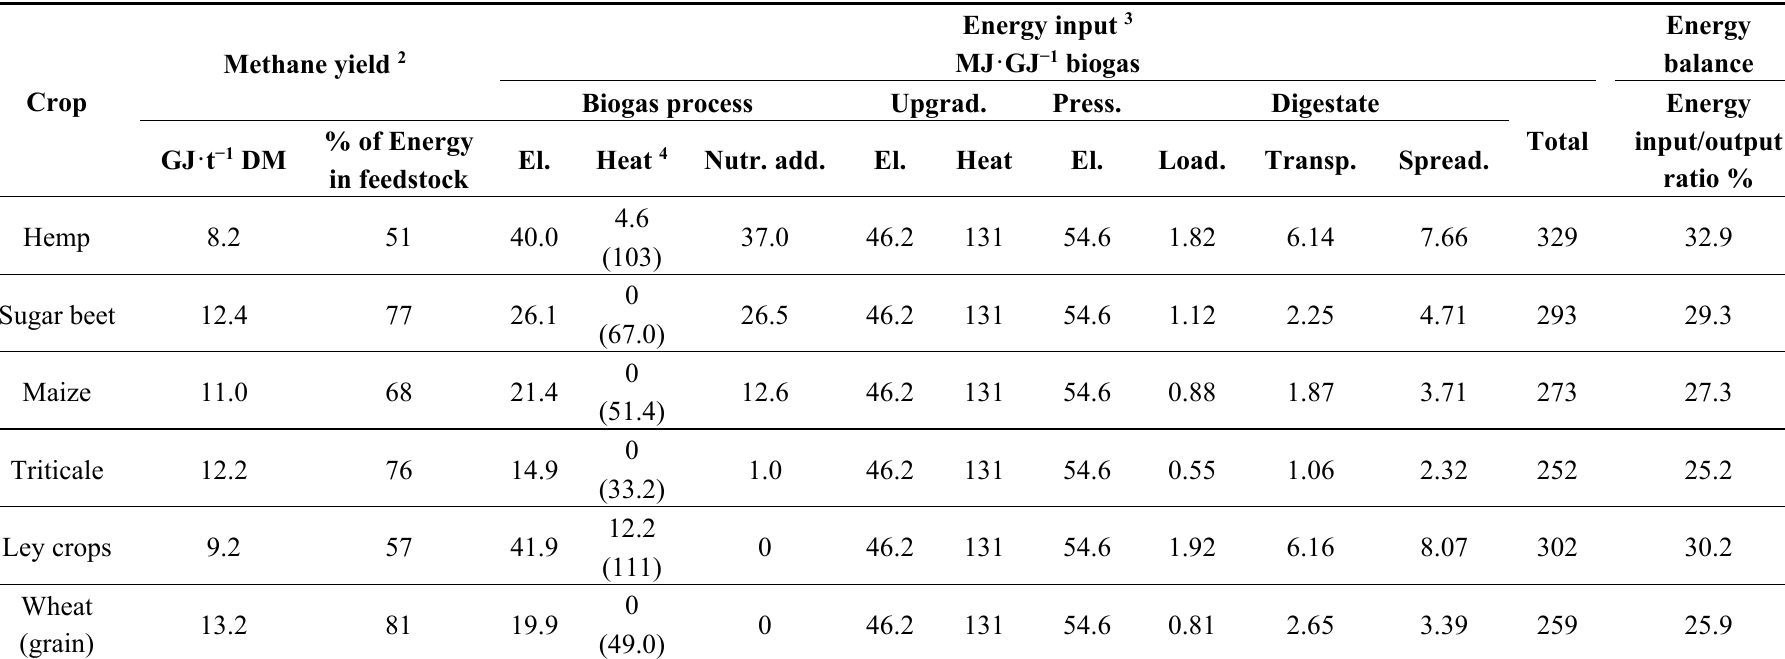
Table 3. Methane yields and energy inputs in the conversion system of energy crops into upgraded and pressurised biogas, including use of digestate as biofertiliser 1